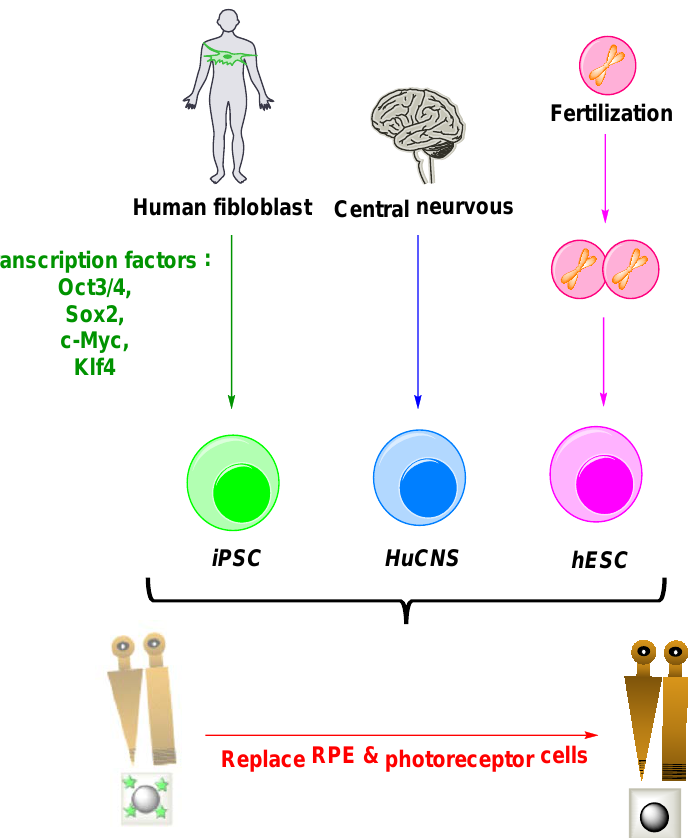
Figure 16. Stem cells therapy for the regeneration of RPE and photoreceptor cells. Three different types of SC are currently used: SC issued from fibroblasts (iPSC), SC from the central nervous sys- tem (HuCNS) and embryonic stem cells (hESC). Oct3/4: octamer-binding transcription factor 3/4, Sox2: SRY (sex determining region Y)-box 2, c-Myc: cellular Myelocytomatosis, Klf4: Kruppel-like factor 4.